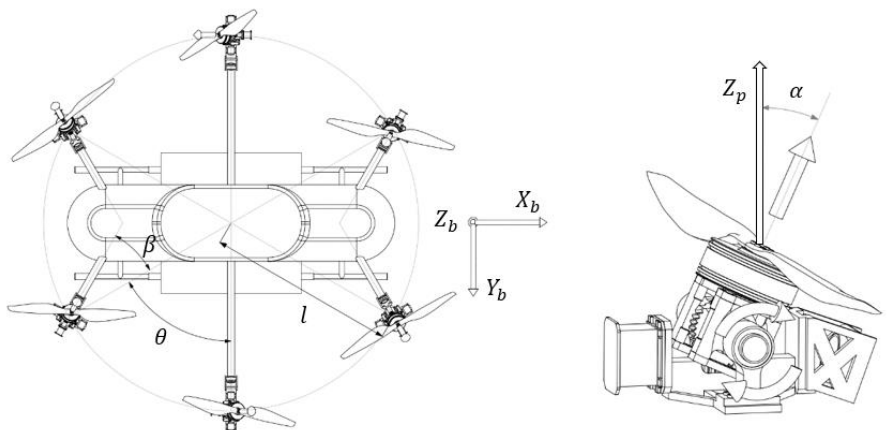
Figure A1. Structural layout of proposed UAV.